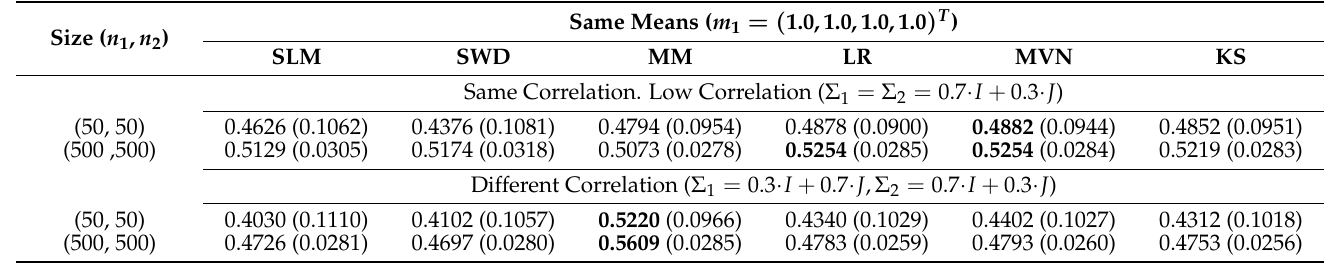
Table 14. Normal distributions: Same means.